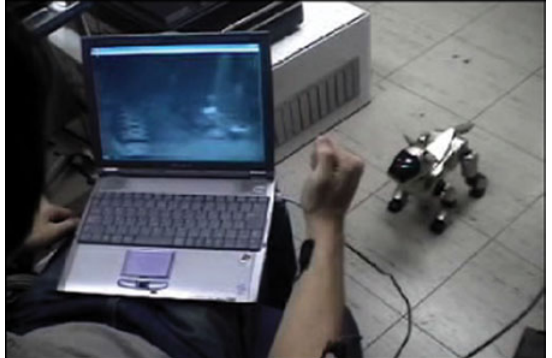
Figure 5 AIBO control with CCD camera.